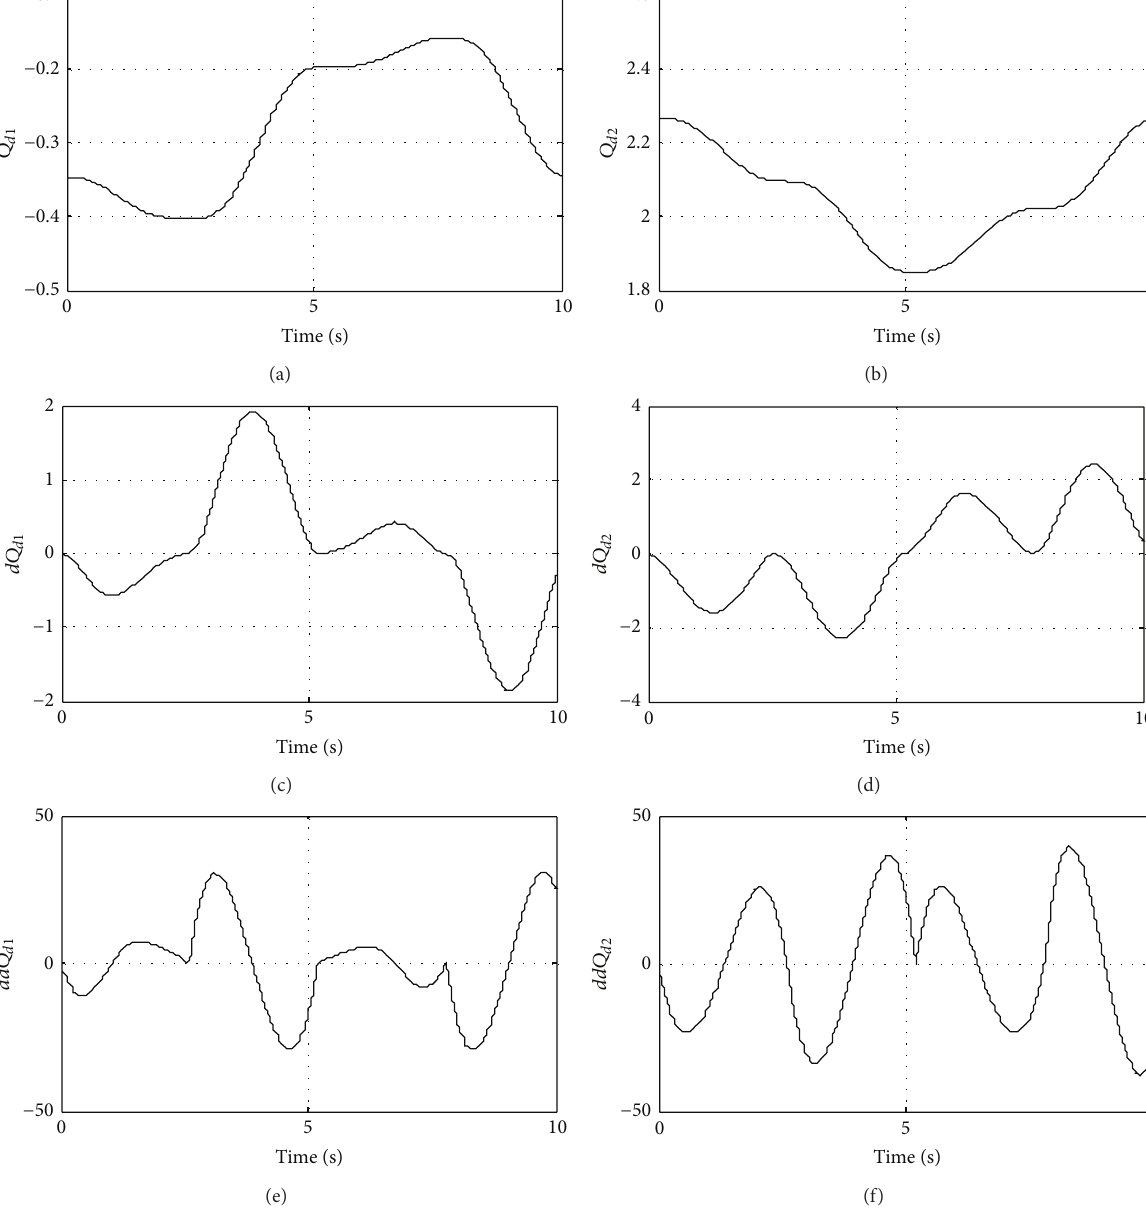
Figure 6: Desired virtual space trajectories: (a)-(b) position trajectories, (c)-(d) velocity trajectories, and (e)-(f) acceleration